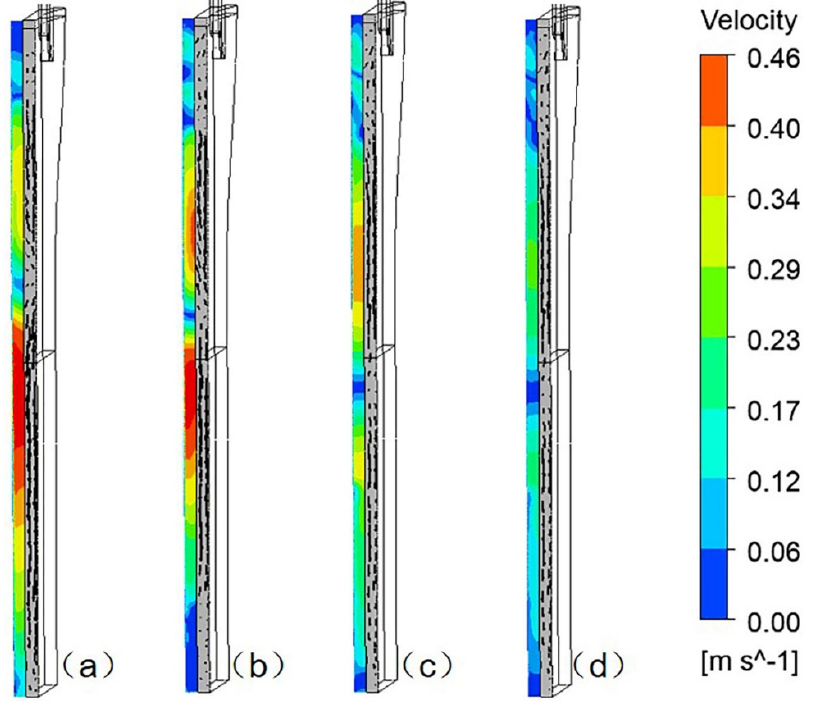
Figure 12. Funnel mold narrow face velocity distribution and vector diagram. ( a ) No EMBr, ( b ) 300–200, ( c ) 800–600 and ( d ) 1100–800 A.